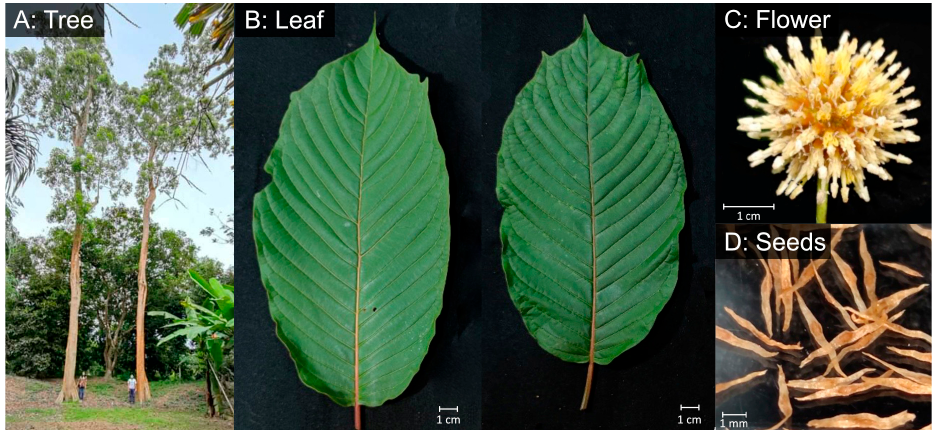
Figure 1. Morphology of M. speciosa. ( A ) Tree, ( B ) leaves, ( C ) flower, and ( D ) seeds.